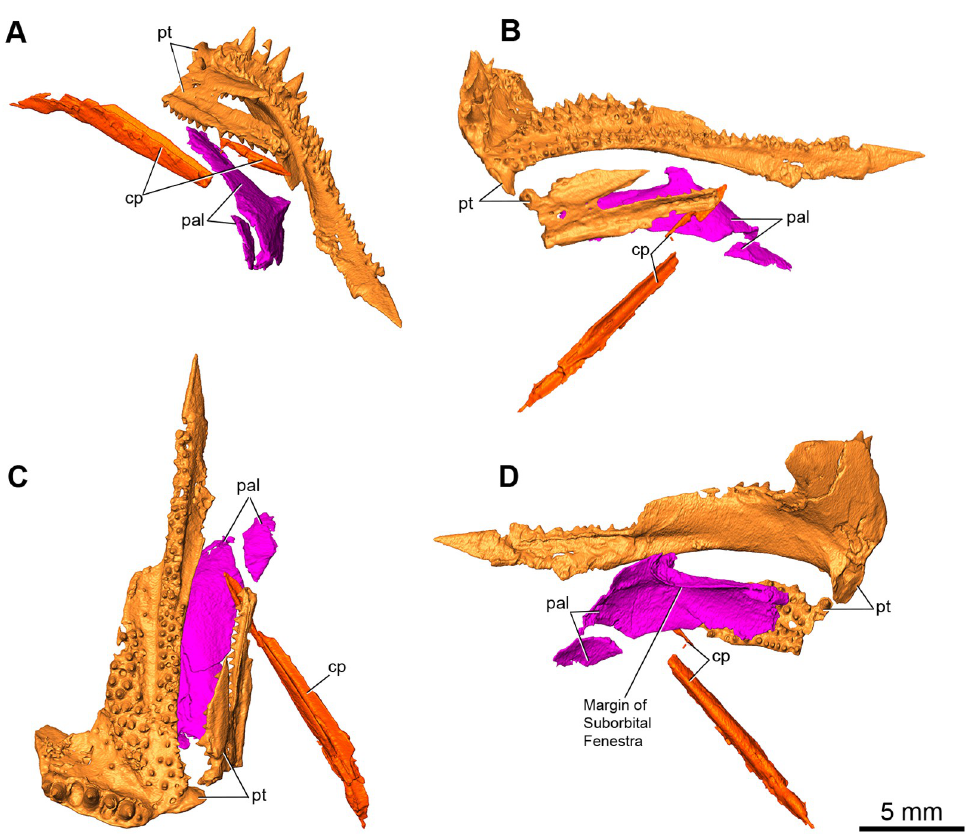
Fig 5. Rendering of palatal elements present in Maiothisavros dianeae (ROMVP 87366) from CT image sequences. Palatal elements, including right and left pterygoid, palatine, and cultriform process in (A) anteroposterior, (B) left lateral, (C) ventral, and (D) dorsal views. Abbreviations: cp, cultriform process; pal, palatine; pt, pterygoid.